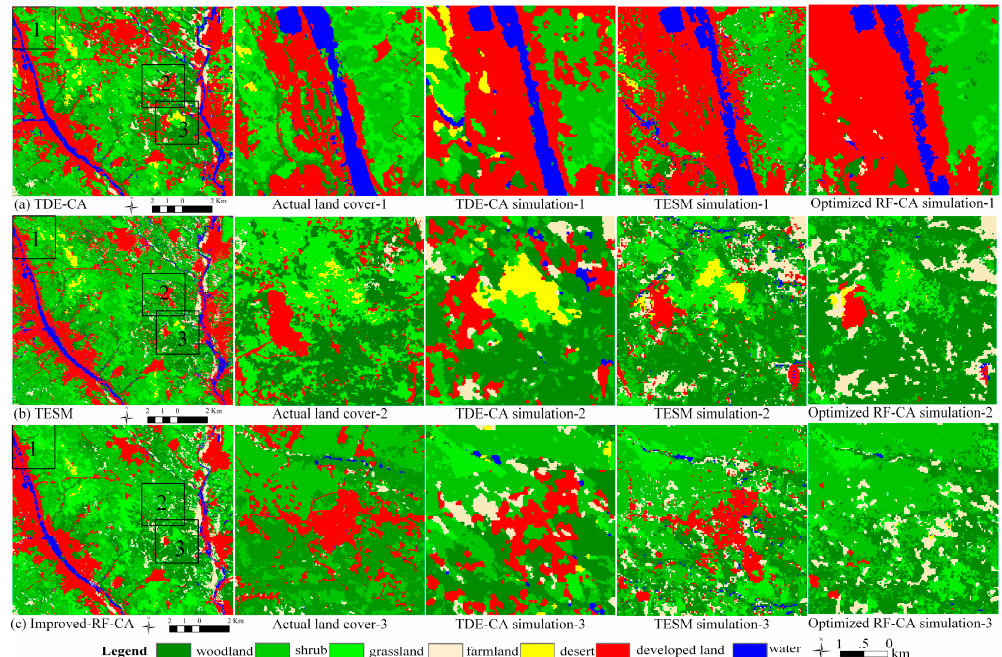
Figure 6. The spatial distribution and partial enlargements of land cover. ( a – c ) respectively present the land cover simulation of the TDE-CA, the TESM, and the optimized RF-CA.